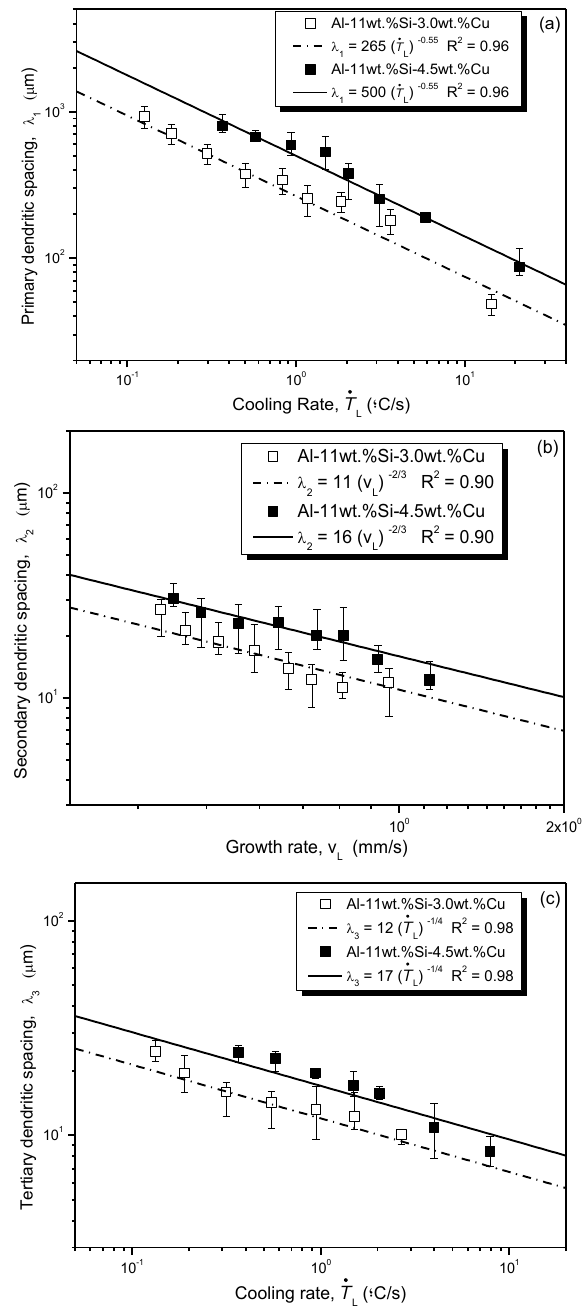
Figure 9. Experimental variations characterizing: ( a ) primary dendrite arm spacing, λ 1 , vs. cooling rate, ( b ) secondary dendrite arm spacing, λ 2 , vs. growth rate, and ( c ) tertiary dendrite arm spacing, λ 3 , vs. cooling rate of the Al-11wt %Si- x wt %Cu alloys. R 2 is the coefficient of determination. Circulating between the dendrites is a liquid rich in solute. The dendritic array is formed by